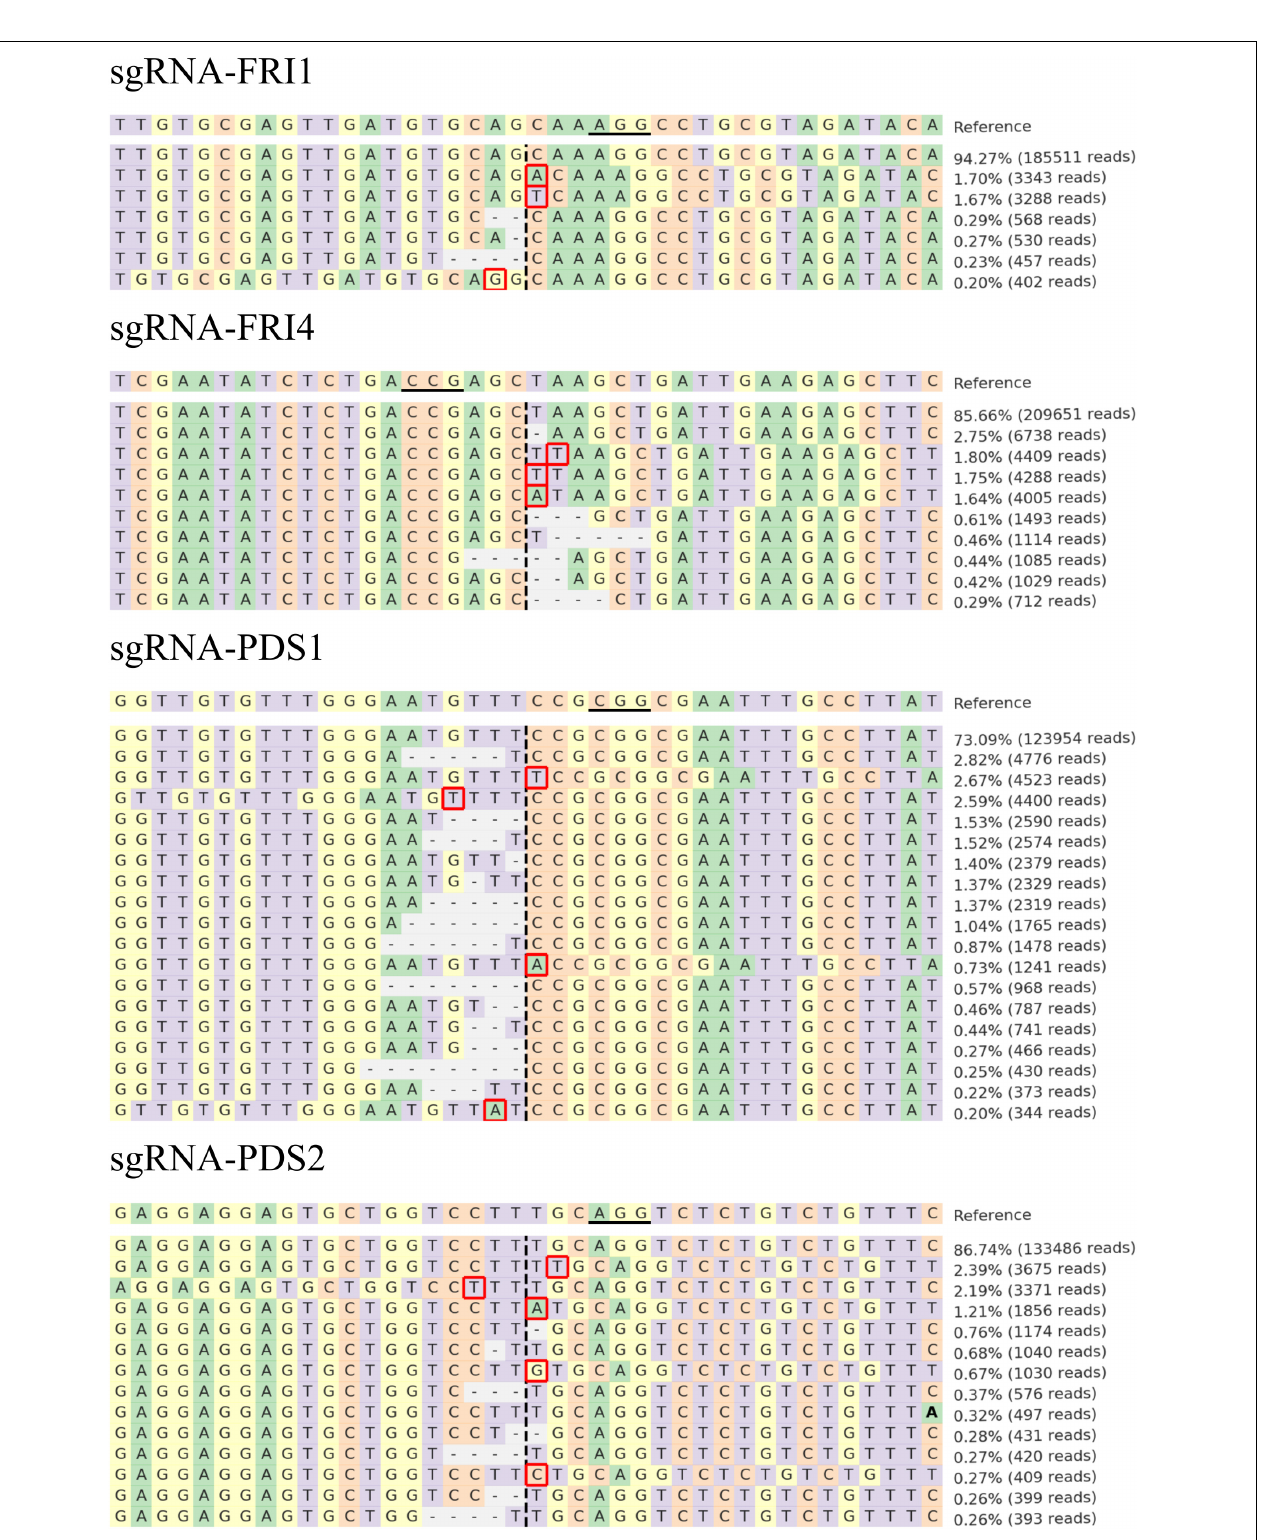
FIGURE 3 | Distribution of the most frequent alleles identified with CRISPResso around cleavage sites in B. rapa. Sequences were obtained after transfection with 60 µ g Cas9 preassembled with 60 µ g of sgRNA-FRI1, sgRNA-FRI4, sgRNA-PDS1, or sgRNA-PDS2. The horizontal line indicates the PAM region, the vertical dashed line indicates the predicted cleavage site. Mutations are shown in bold font (substitutions), highlighted with red rectangles (insertions), or marked with horizontal dashed lines (deletions).